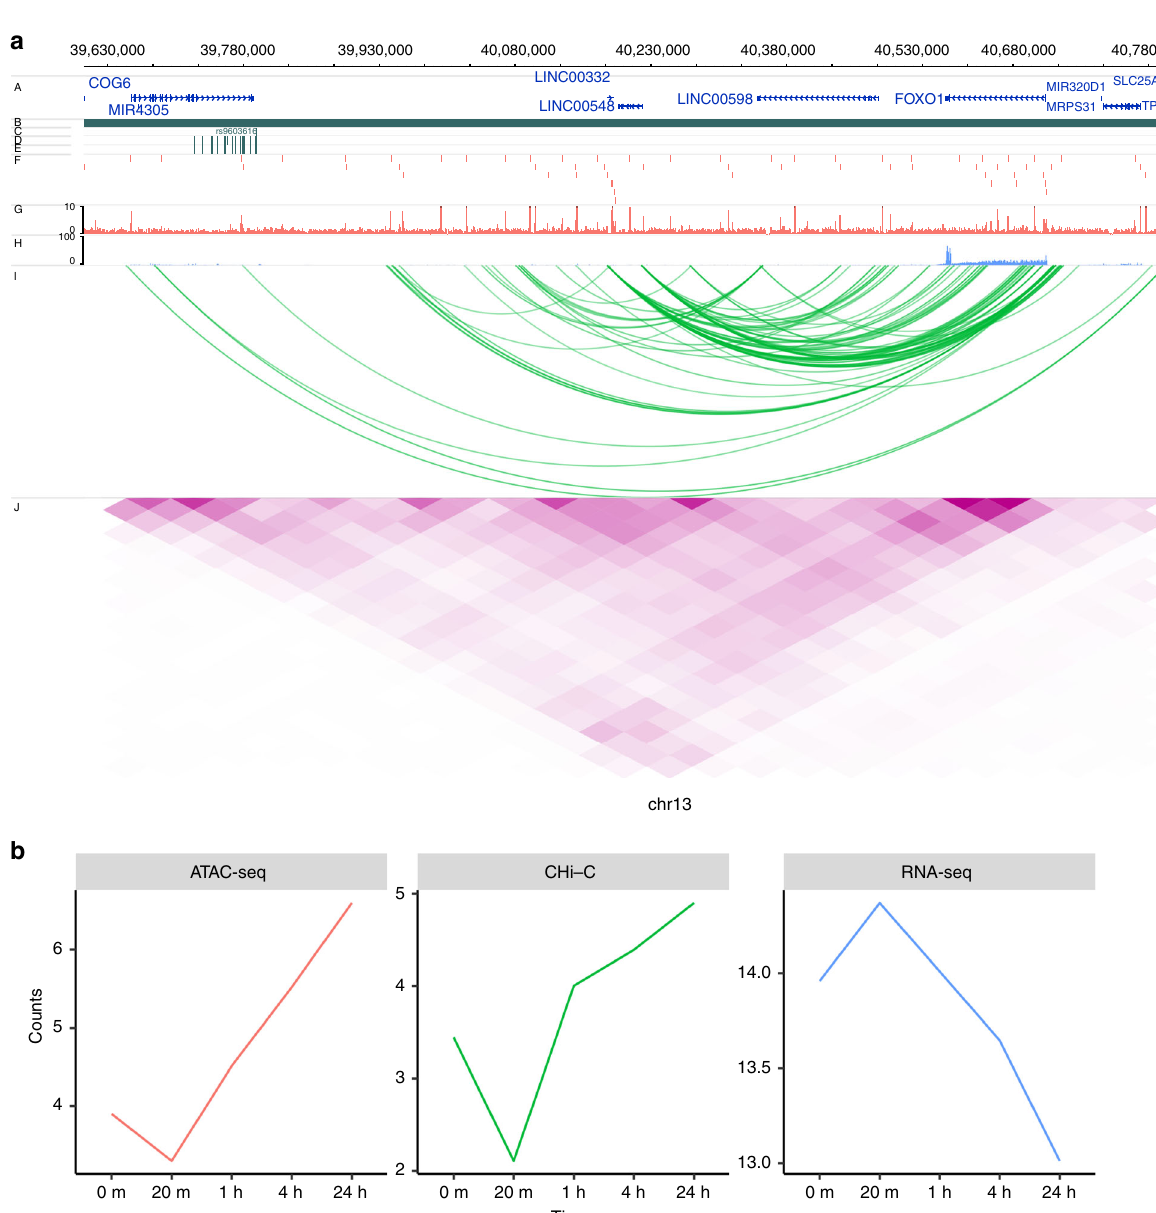
Fig. 6 Illustration of genomic interaction activities around FOXO1. a Screenshot of the SNPs (dark green), ATAC-seq peaks (red), RNA-seq (lightblue), CHi-C interactions (green) and heatmap from Hi-C (purple) around FOXO1 at time 4 h. y -axis labels A – J represent different tracks plotted. A RefSeq genes, B TADs, C Index SNPs, D LD SNPs, E 99% credible sets, F ATAC-seq peaks, G ATAC-seq signal, H RNA-seq, I CHi-C, J Hi-C. b Time course pro fi les of ATAC-seq (left), Chi-C (middle) and RNA-seq (right) of the data associated with SNPs data around